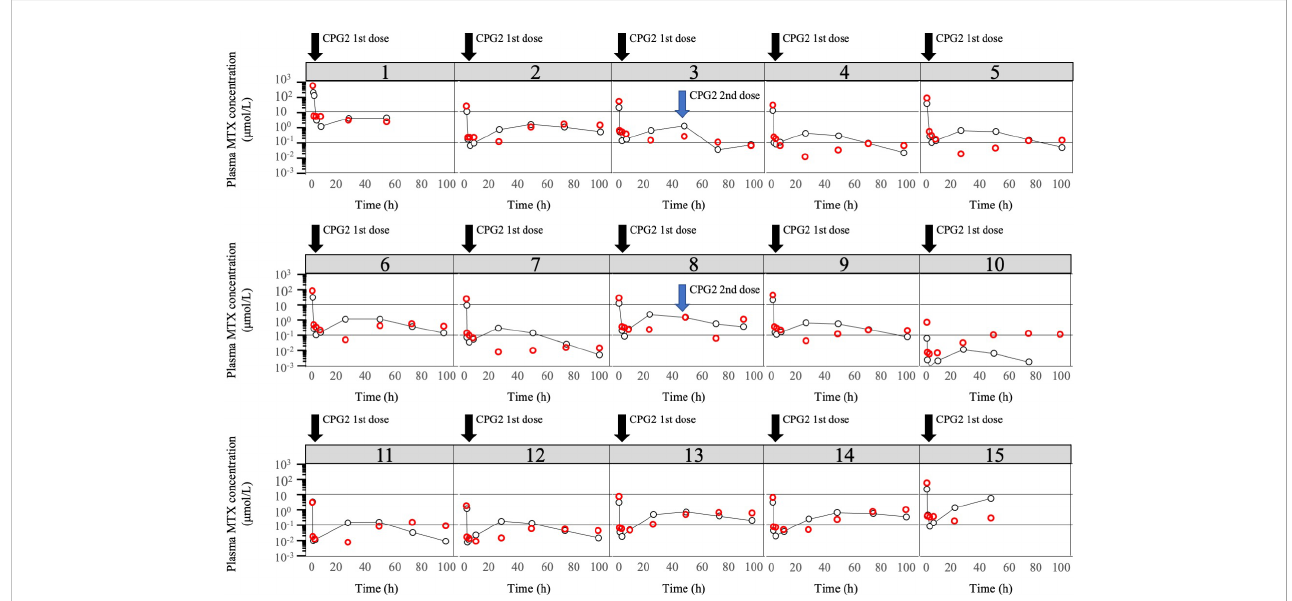
FIGURE 6 Plot of logarithm of observed plasma MTX concentrations and predicted plasma MTX concentrations. Observed plasma MTX concentrations (red cycle) and predicted plasma MTX concentrations (black cycle) using the CPG2-MTX popPK-PD fi nal model versus time in the phase 2 study individual patients ( N = 15). The two solid black lines represent plasma methotrexate concentrations of 0.1 and 1 m mol/L,